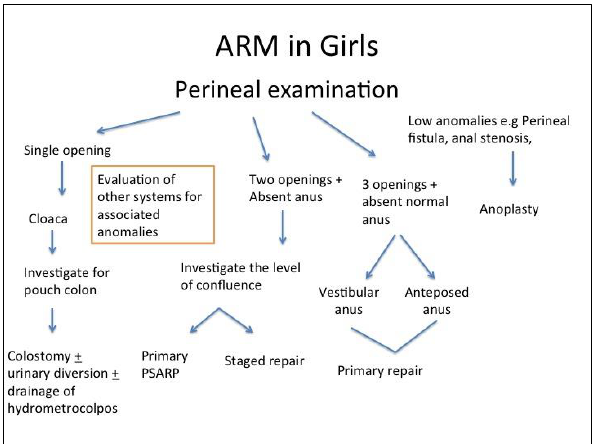
Figure 4: Algorithm for management of female Anorectal malformations at